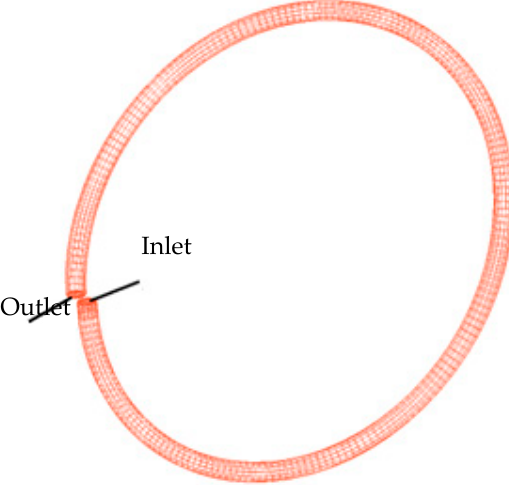
Figure 3. Computational grid of element helical tube.